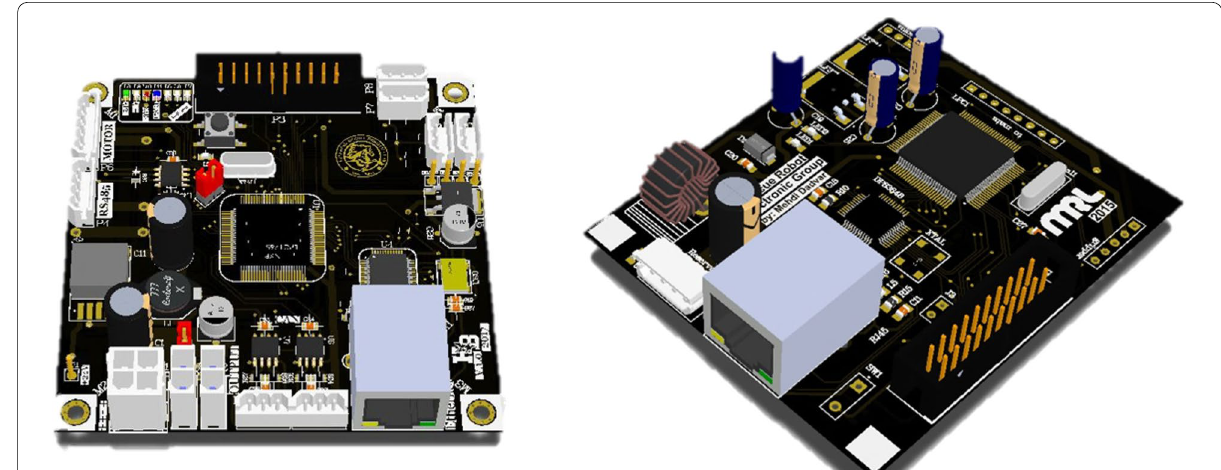
Fig. 14 Hardware design of (left) the manipulator controller board, and (right) the end-effector board